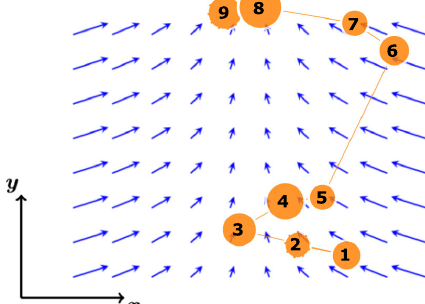
FIG. 2. Excerpt of an individual gaze plot during problem solving. Regular eye movement alternates between fixations (orange circles, centered at the position of fixation) and saccades (lines between fixations). Increasing numbers reflect the chrono- logical order of fixations, and the size of the circles illustrates the duration of the fixation. A short video sequence can be found in the Supplemental Material